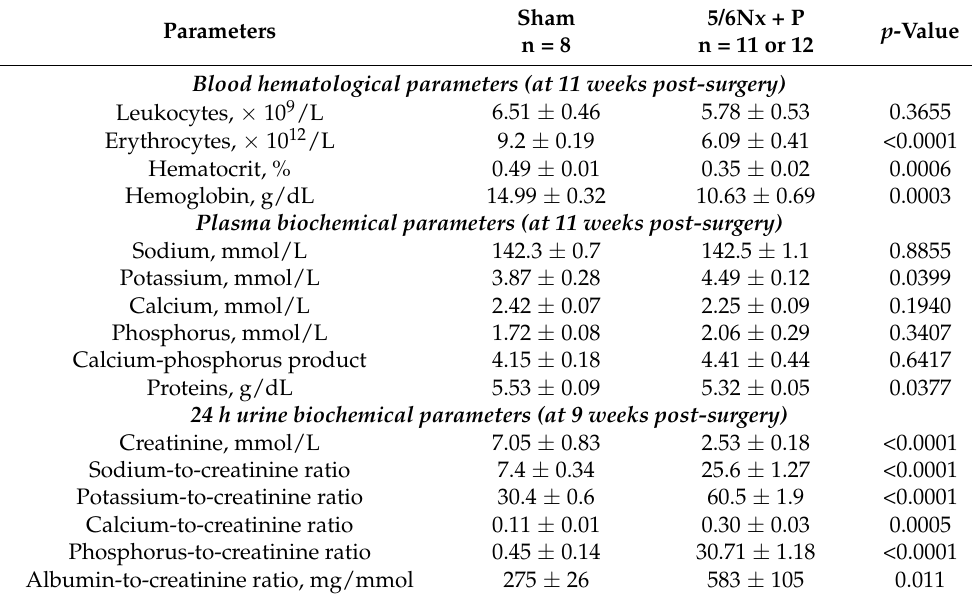
Albumin-to-creatinine ratio, mg/mmol